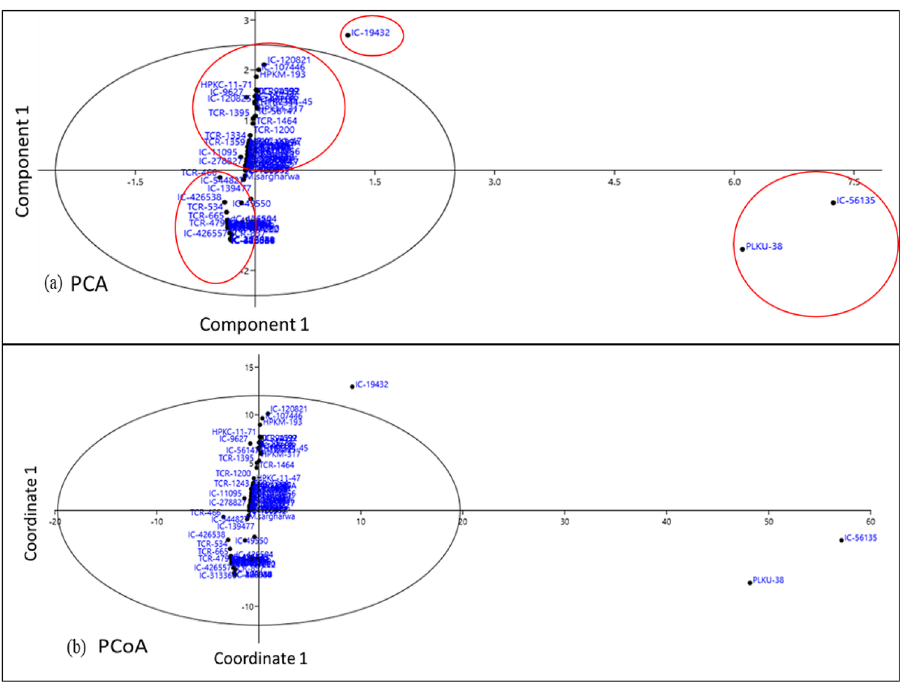
Figure 4. ( a ) PCA and ( b ) PCoA for diverse panel of horsegram germplasm on the basis of the identified metabolites. *PCA: Principal components analysis, PCoA: Principal coordinates